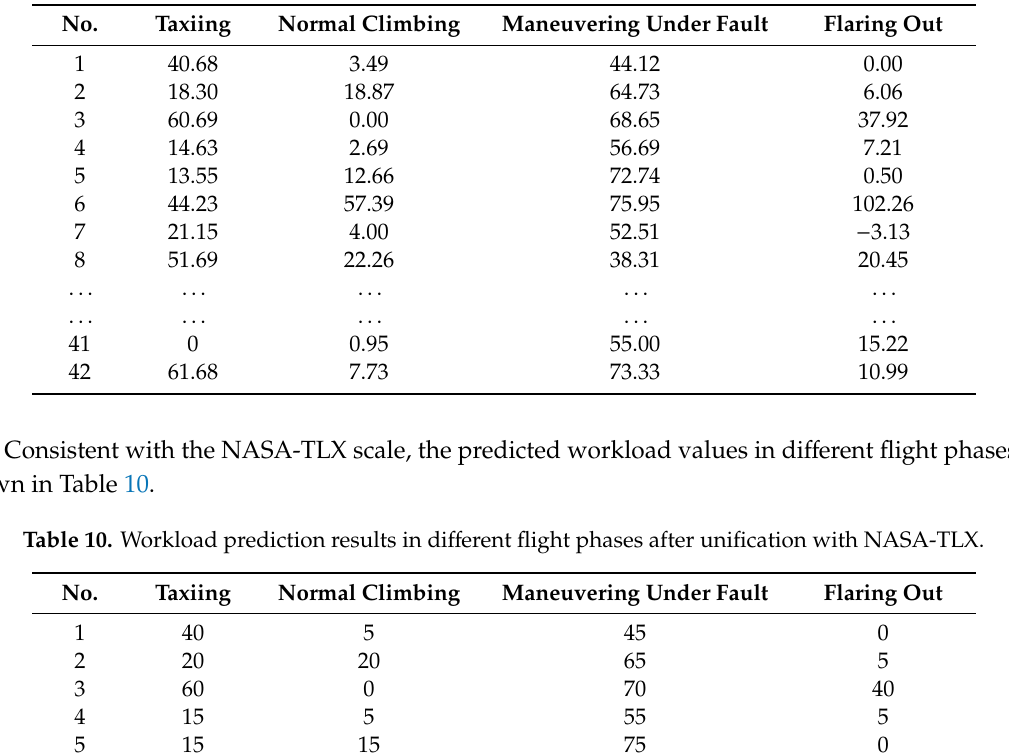
Table 9. Workload prediction results in di ff erent flight phases.